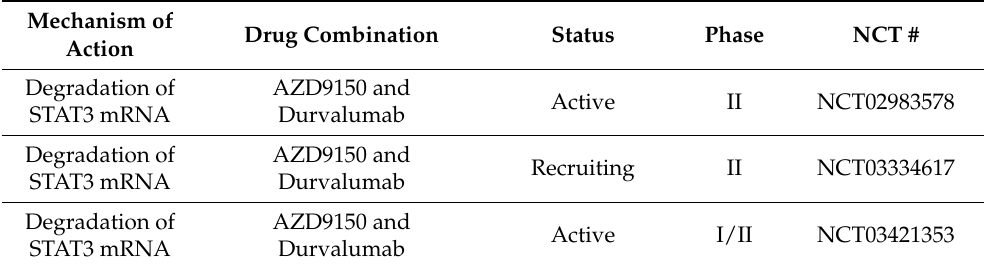
Table 3. Clinical trials combining STAT3-targeting agents with immune checkpoint inhibitors in